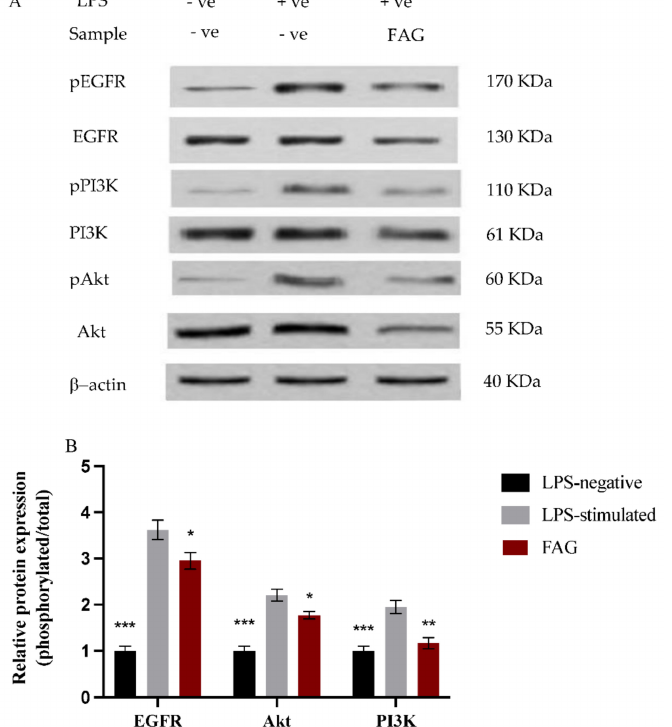
Figure 6. Effect of FAG on the expression of EGFR, Akt, and PI3K proteins on LPS-stimulated RAW 264.7 cells. ( A ) Representative western blots of phosphorylated and total EGFR, Akt, and PI3K proteins in LPS-stimulated RAW 264.7 cells treated with the new FAG. As an internal control, β -actin was used. ( B ) Relative phosphorylated/total protein expression ratio in RAW264.7 with/without LPS stimulation and after treatment with the FAG. Data were normalized to the corresponding β -actin protein expression and expressed relative to that of LPS-untreated RAW 264.7 cells. Bars represent mean ± SD. Significance was analyzed by one-way ANOVA test, where ***; p < 0.001, **; p < 0.01, *; p < 0.05, compared to untreated LPS-stimulated RAW 264.7